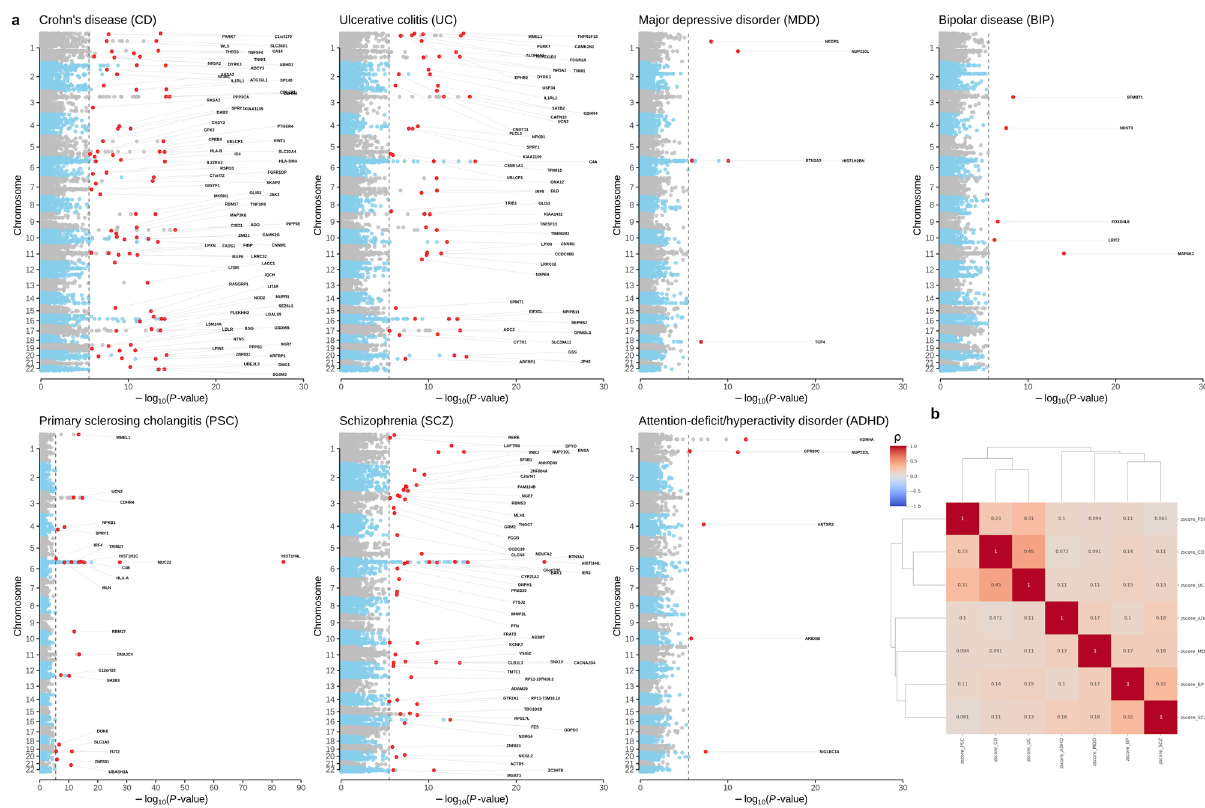
Fig. 2 Manhattan plots showing transcriptome-wide signi fi cant ( P conditional < 3.20 × 10 − 6 from GBJ conditional ) gene discoveries for psychiatric and immune phenotypes in 23 gut-brain-axis (GBA) tissues, and proportion of shared predicted transcriptome-wide disease-associated gene expression ( ρ E ) for pairs of immune-mediated and psychiatric diseases averaged across 23 tissues of the GBA. a Gray dotted line, transcriptome-wide signi fi cance threshold; red dots, lead gene-disease associations at TWAS loci (for regions of size ±1 Mb) and conditioned on all genes within ±1 Mb regions. CD Crohn ’ s disease, UC ulcerative colitis, PSC primary sclerosing cholangitis, SCZ schizophrenia, MDD major depressive disorder, BIP bipolar disease, ADHD attention-de fi cit/hyperactivity disorder. b Spearman ’ s trait correlation ( ρ ) values at the transcriptome-wide level of gene expression for each disease pair and averaged across 23 tissues of the GBA show that effects of genetic risk variants shared between psychiatric and immune phenotypes are largely mediated by gene expression. Strongest positive correlations across psychiatric and immune phenotypes were observed for pairs UC and BP ( ^ ρ E = 0.15), CD and BP ( ^ ρ E = 0.14), UC and SCZ ( ^ ρ E = 0.13), and CD and SCZ ( ^ ρ E = 0.11), which is in line with genome-wide genetic correlations ( ^ ρ G ) for pairs UC and BP ( ^ ρ G = 0.23), CD and BP ( ^ ρ G = 0.22), UC and SCZ ( ^ ρ G = 0.14), and CD and SCZ ( ^ ρ G = 0.12) reported by Tylee et al. 11 . The dendrogram re fl ects the corresponding hierarchical single linkage clustering across diseases. Genetic trait correlations for single-tissue results (analysis Single-tissue conditional ) are given in Supplementary Data 9, 10. For the selection of 23 tissues, see Fig. 1, Supplementary Data 2, and Methods. Results from unconditioned cross-tissue TWAS analysis (GBJ marginal ; before multiple-gene-conditioned fi ne-mapping analysis) are shown in Supplementary Fig.